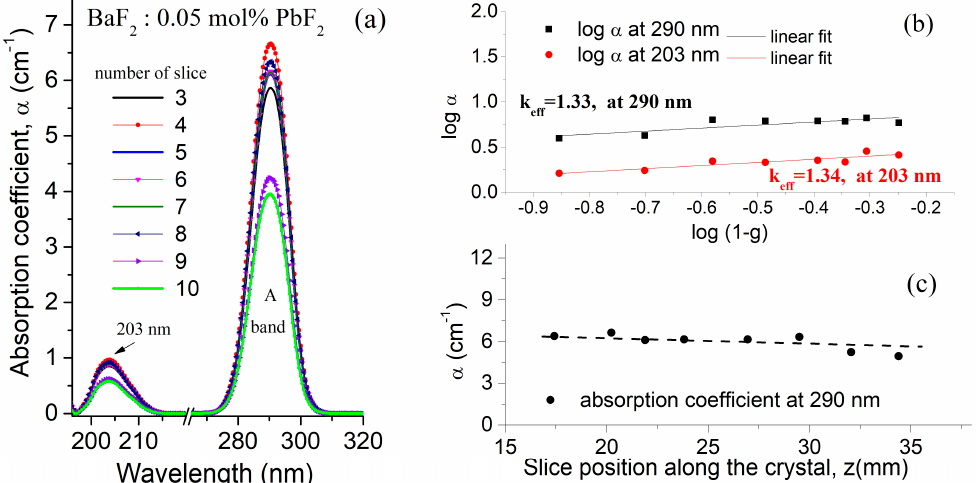
Figure 7. ( a ) Optical absorption spectra of various slices cleaved from 0.05 mol% PbF 2 -doped BaF 2 crystal (the A and D bands); ( b ) fitting lines of log α (z) vs. log (1 − g) in order to calculate the effective distribution coefficient; ( c ) absorption coefficient of Pb 2+ ions for various slice positions in the crystal (the Pb 2+ ion concentration variation along the crystal).